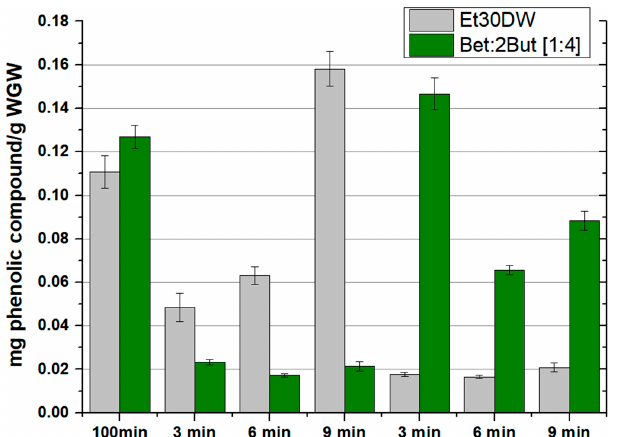
Figure 4. Phenolic compounds extracted according to the orbital shaker extraction (OSE) or microwave-assisted extraction (MAE) method used and as a function of the evaluated solvent (Et30DW or Bet: 2But [1:4]). Results are expressed as mean values (mg phenolic compounds/g WGW) ± RSD (%).